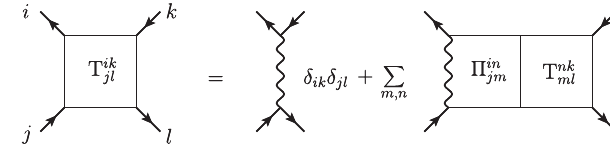
11. Bethe-Salpeter equation for the two-phonon T matrix, indicated by a box. The wavy line denotes the contact interaction with strength g and continuous lines indicate Bogoliubov propagators given in Eq. (58). Indices are Bogoliubov where